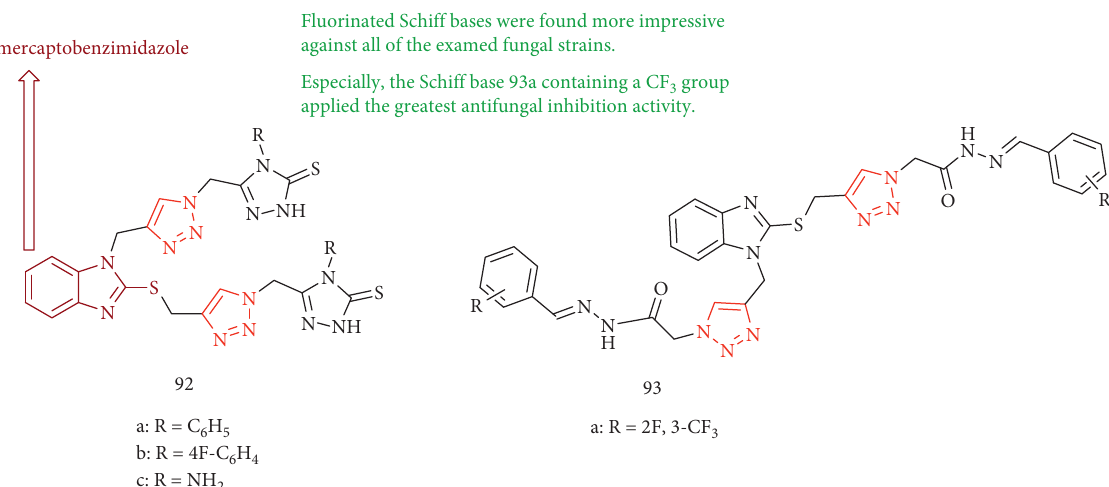
Figure 42: Chemical structure of new polyheterocyclic molecules by clubbing the benzimidazole